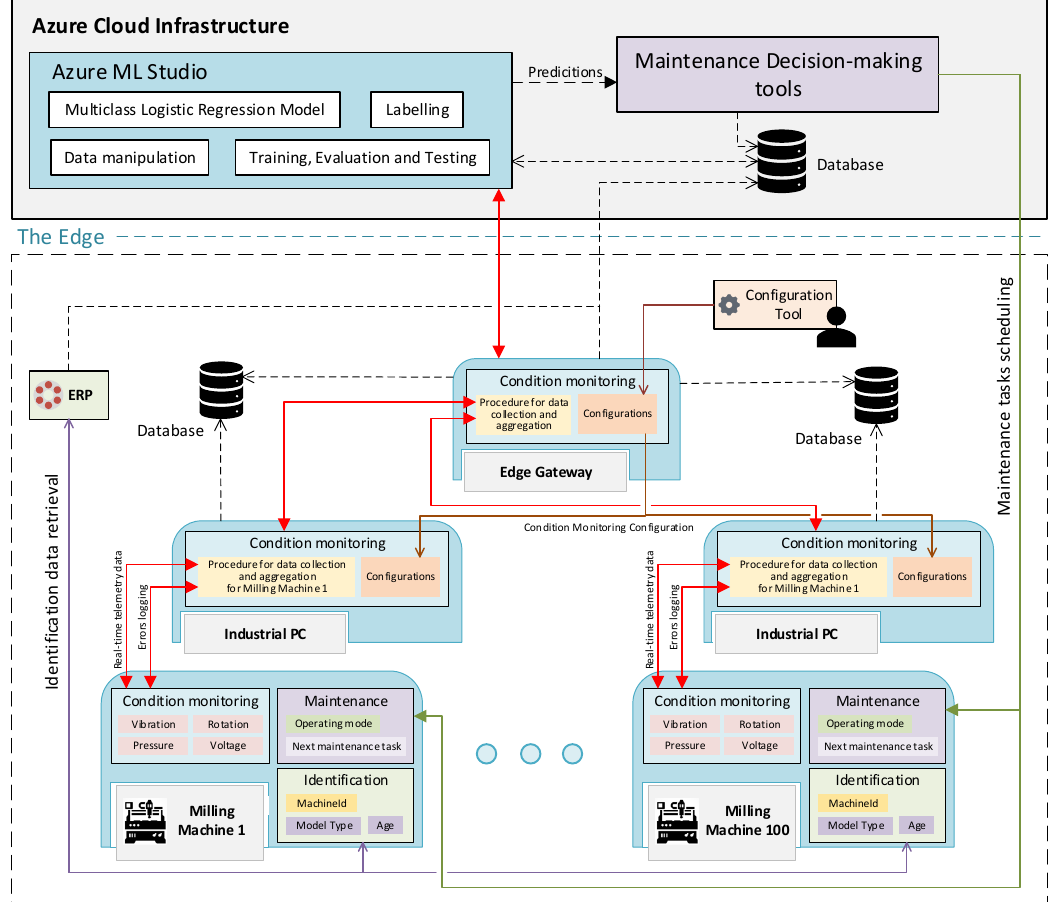
Figure 6. Complete overview of the use case scenario.